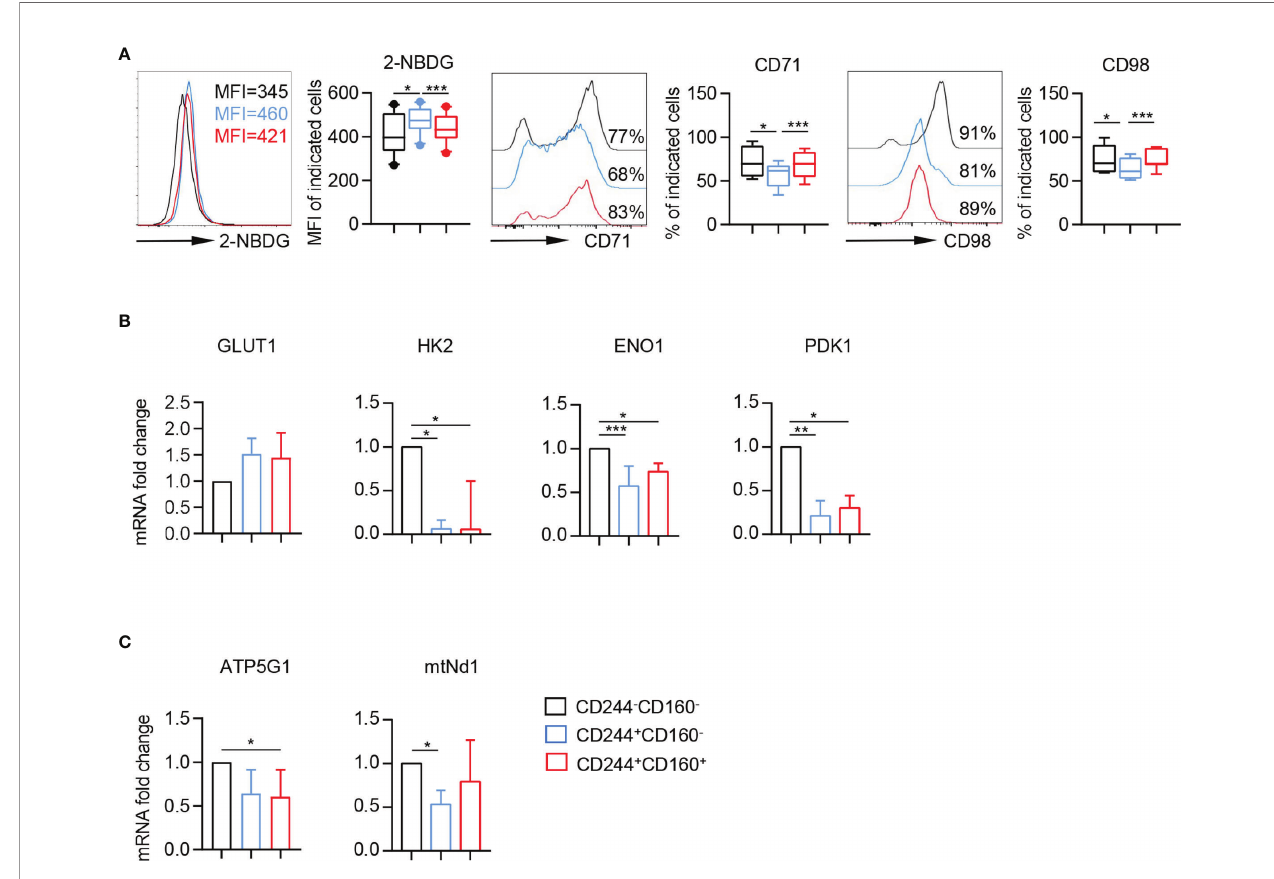
FIGURE 5 | Enhanced glucose uptake and reduced expression of metabolism-associated genes in CD244 + CD160 - CD8 + T cells. (A) Representative histograms (left) and box plots (right) of 2-NBDG uptake or CD71 and CD98 expression in CD244 - CD160 - , CD244 + CD160 - and CD244 + CD160 + CD8 + T cells (n = 7-10). P values were obtained by repeated-measures ANOVA followed by Tukey ’ s multiple comparisons test. (B, C) Differential effects of CD244 and CD160 on markers of the glycolysis and oxidative phosphorylation in CD8 + T cells from older subjects (n = 5-7). Real-time quantitative PCR analysis of transcript levels of (B) glycolytic enzymes (GLUT1, HK2, ENO1, and PDK1), and (C) oxidative phosphorylation (ATP5G1 and mtNd1) in CD8 + T cells after 4 h of culture in the presence of plate-bound anti-CD3 and anti- CD28 (10 µg/mL). P values were obtained by Friedman ’ s test followed by Dunn ’ s multiple comparisons test. * P < 0.05, ** P < 0.01, *** P <